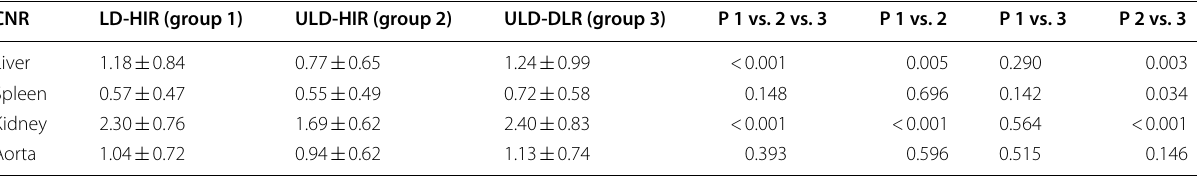
Table 2 Contrast-to-noise ratios (CNRs) for the liver, spleen, kidneys, and aorta